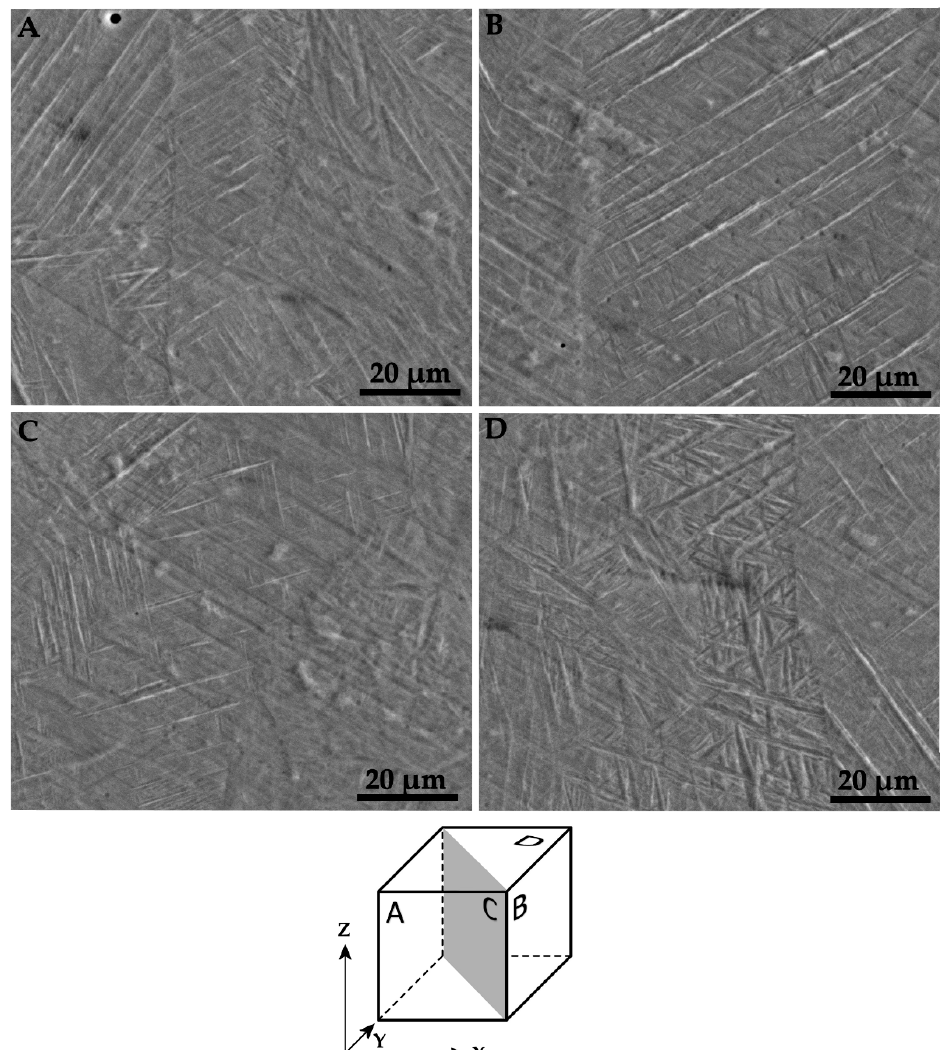
Figure 10. SEM images of etched sections of Ti–6Al–4V specimens. Alignment of the ( A – D ) images is schematized in the cube.